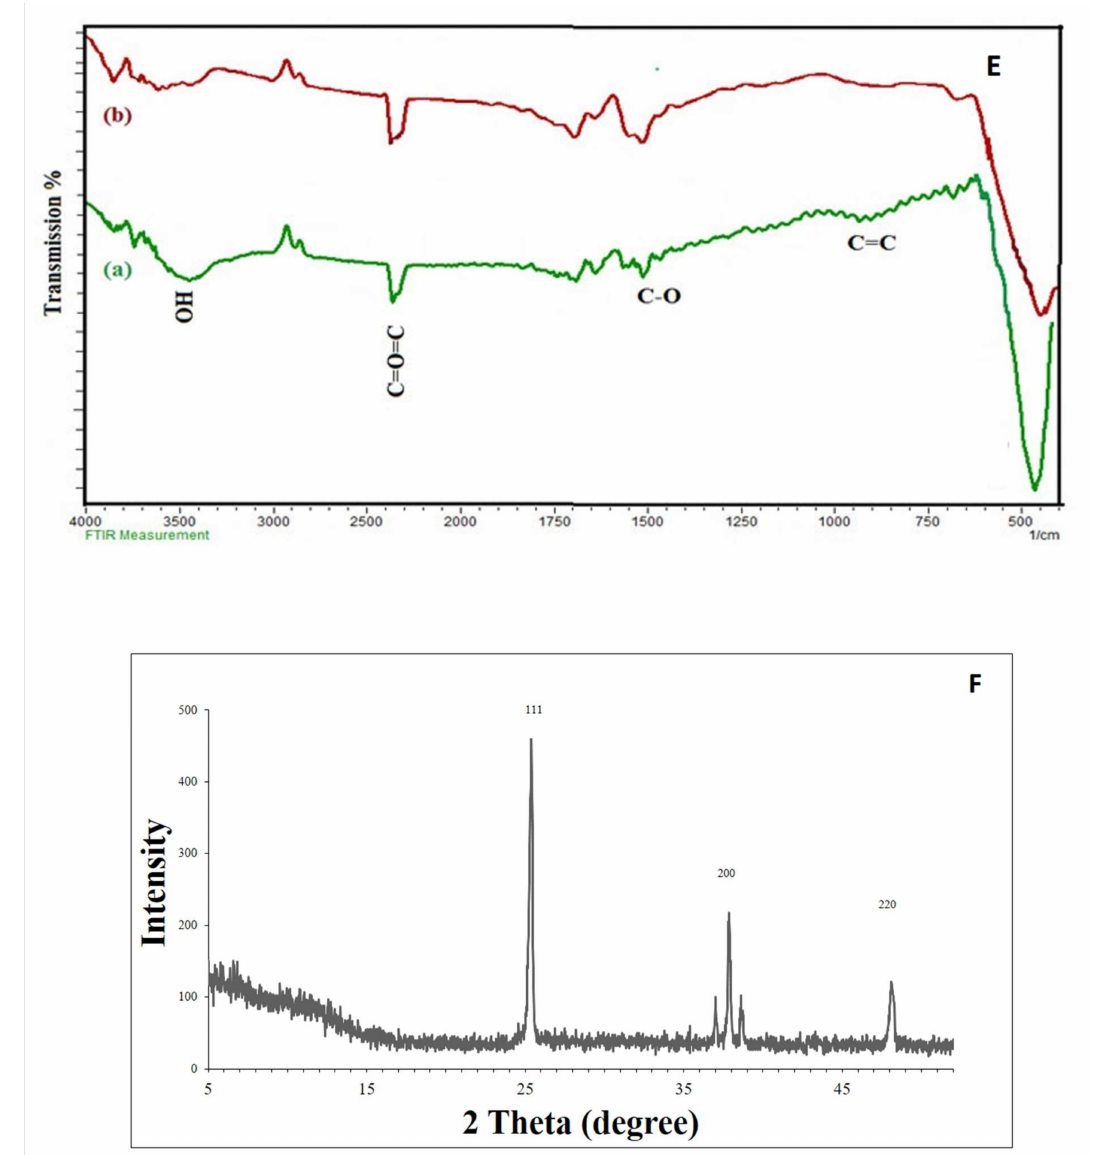
Figure 3. Characterization results of phytogenically synthesized nanomaterials ( A ): UV spec- trum of ZnO; ( B ): UV-spectrum of bimetallic Ag/ZnO nanomaterials); ( C ): scanning electron mi- croscopy micrograph of Ag/ZnO nanomaterials; ( D ): EDX spectrum of Ag/ZnO nanomaterials; ( E ): FTIR spectrum of ( a ) ZnO nanomaterials, ( b ) Ag/ZnO nanomaterials; ( F ): XRD spectrum of Ag/ZnO